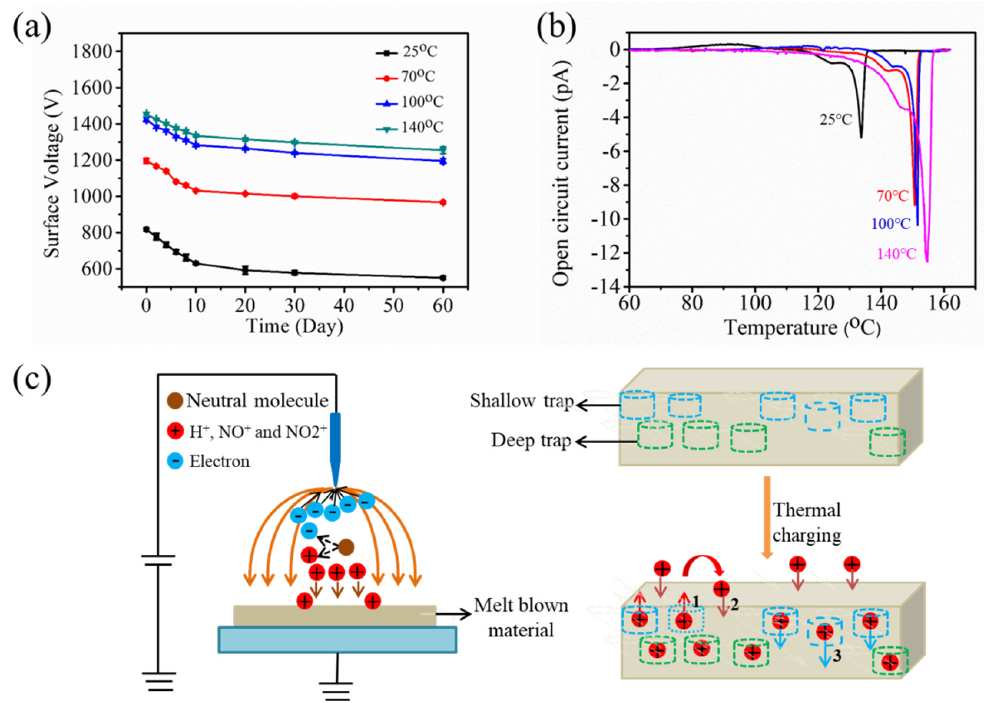
Figure 7. Electret properties of melt blown samples with thermal charging: ( a ) surface voltage decay after two months, ( b ) TSD spectra, and ( c ) schematic of piled charges during the thermal charging process .